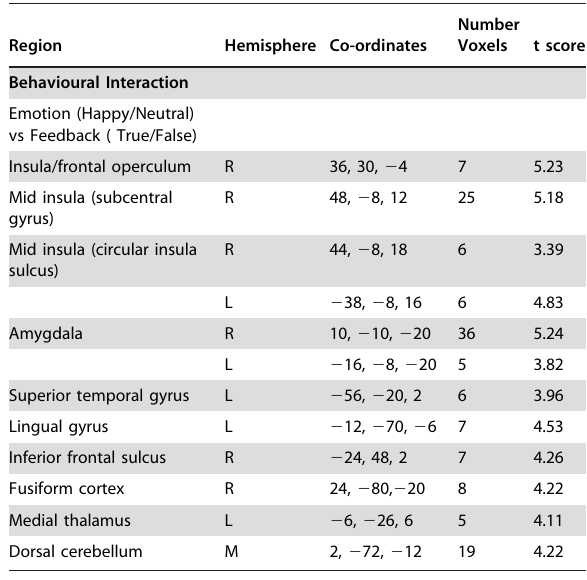
Table 1. Neural Interaction of Emotion and Feedback Veracity. .. ... .... ... ... .... ... ... .... ... ... .... ... ... .... ... ... .... ... ... .... .